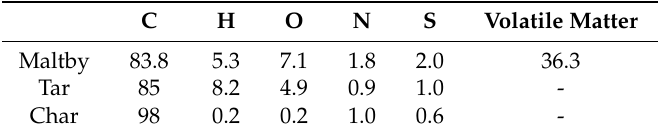
Table 3. Proximate analyses of coal, tar, and coke (wt % daf basis). Reproduced from [41], Elsevier: 1983.